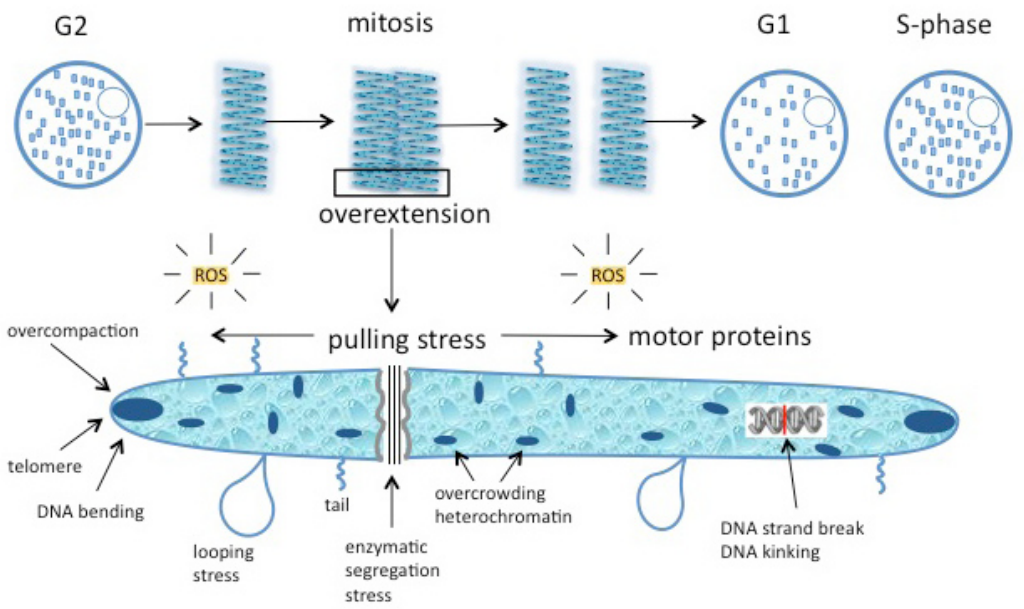
Fig. 3: Four proposed properties of flavanols to counteract harmful effects during mitotic destabilization of the chromosomes. 1. Affinity of flavanols to DNA and histones might provide more stability against too strong bending, compaction, stretching and breakage of chromo- somes, especially with regards to exposed tails and loops. 2. Flavanols are involved in optimal balancing of enzymatic activities, for example of separases, RNAses and polymerases. 3. Flavanols act in oxygen radical scavenging to allow a reductive nuclear milieu being favourable for mitosis and growth promotion. 4. Flavanols bind to specific histone proteins in dependence on the epigenetic histone code, and thus influence directly the gene activity.